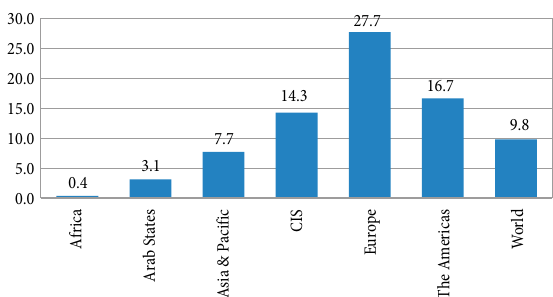
Fig. 2. Fixed (wired) broadband subscriptions (in millions) per 100 inhabitants (2014) Source : ITU (2014).